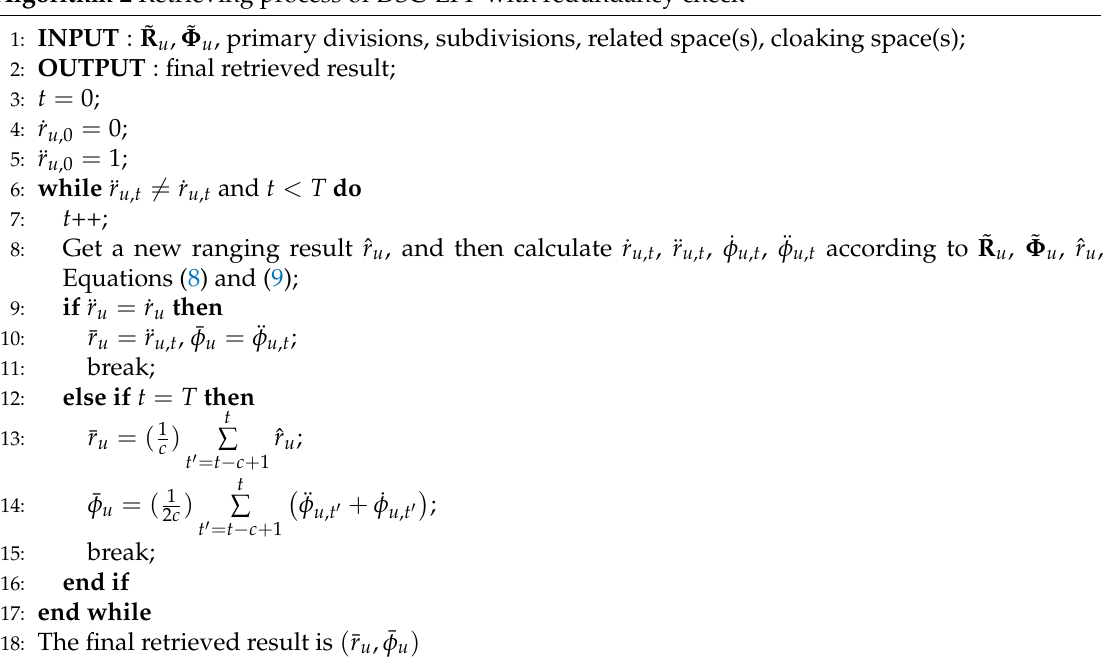
Algorithm 2 Retrieving process of DSC-LPP with redundancy